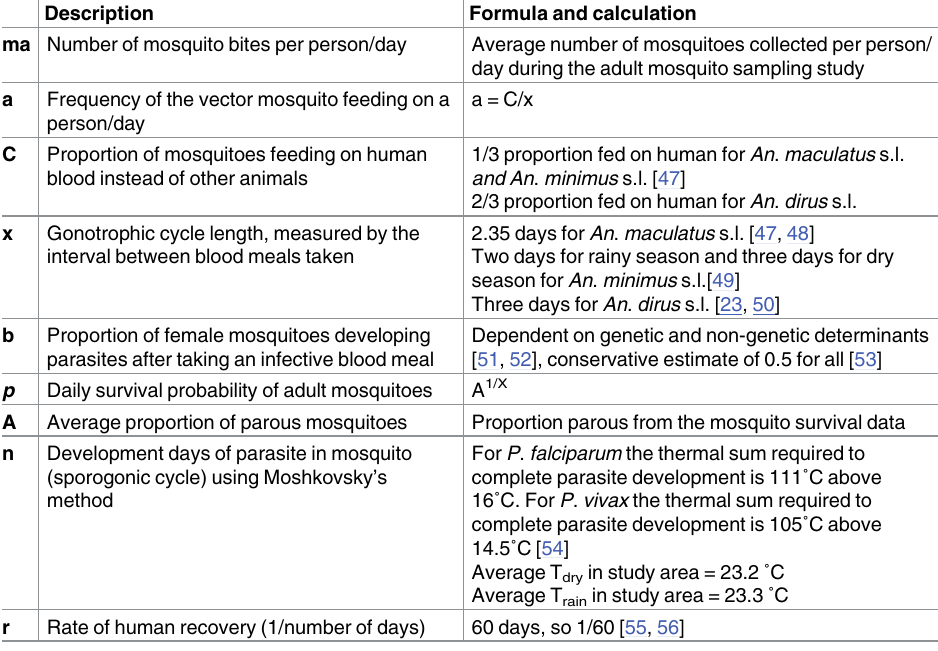
Table 2. Description of the parameters used for the malaria basic reproductive number